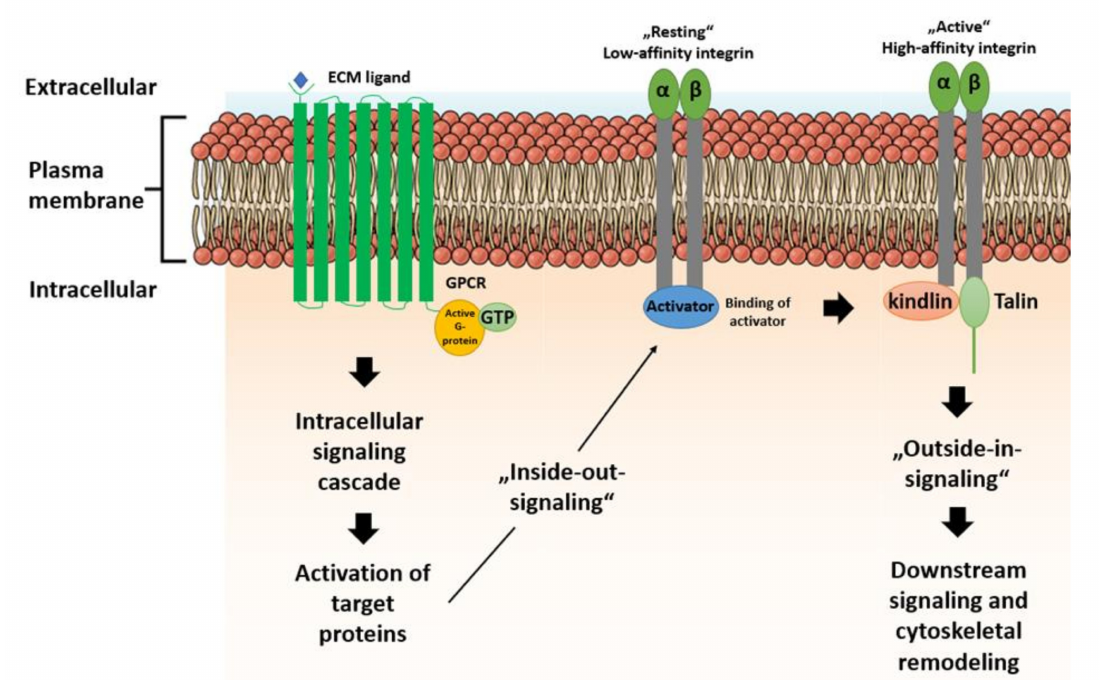
Figure 1. Inside-out and outside-in signaling. Binding of an extracellular matrix (ECM) ligand induces activation of the G-protein receptor. The active G protein initiates an intracellular signaling cascade to activate downstream e ff ectors such as activator proteins, which turn the integrins from a resting to an active state, and which sets up the binding of talin and kindlin to the cytoplasmic integrin domains. This induces outside-in signaling and initiates further downstream processes for subsequent cytoskeletal